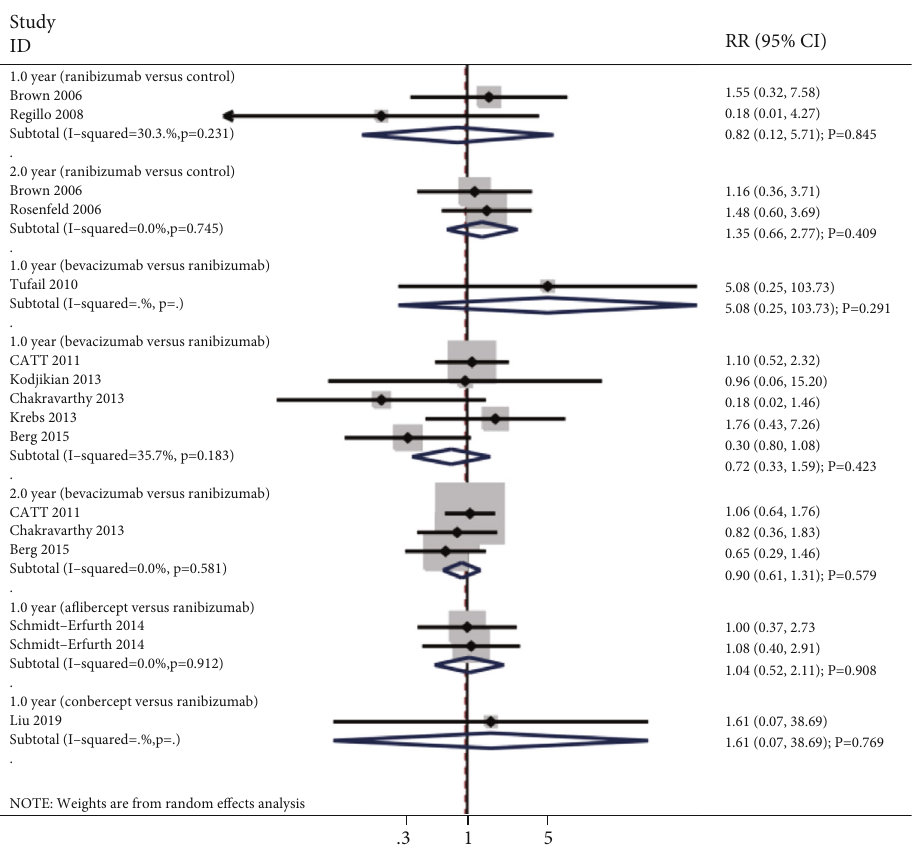
Figure 6: E ff ect of anti-VEGF inhibitors on the risk of arteriothrombotic